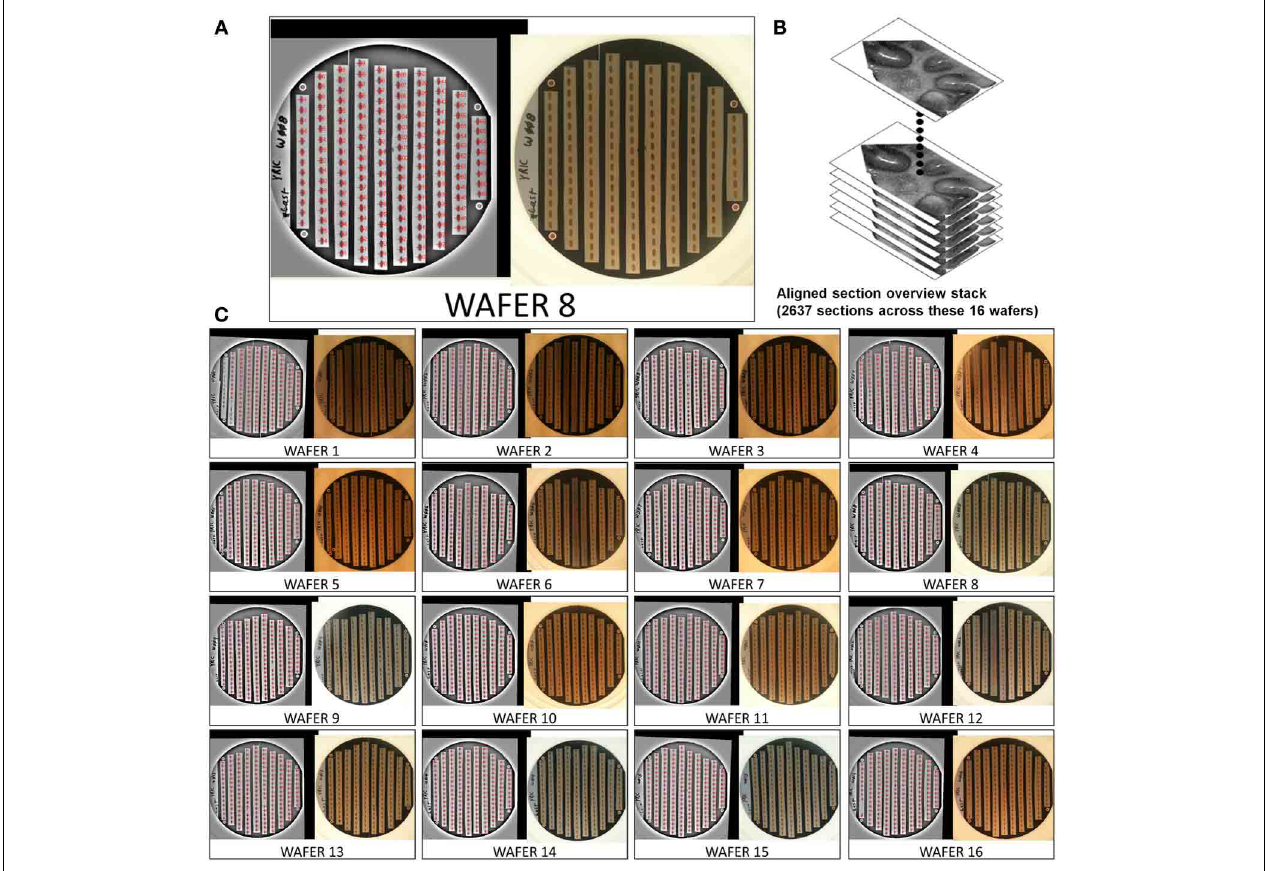
FIGURE 5 | Example of a 2637 section UTSL of mouse cerebellum tissue spanning16wafers. Anopticalimageofeachwaferwastakenandusedasthe basis of automapping all sections. (A) Optical image of wafer 8 (right), filtered